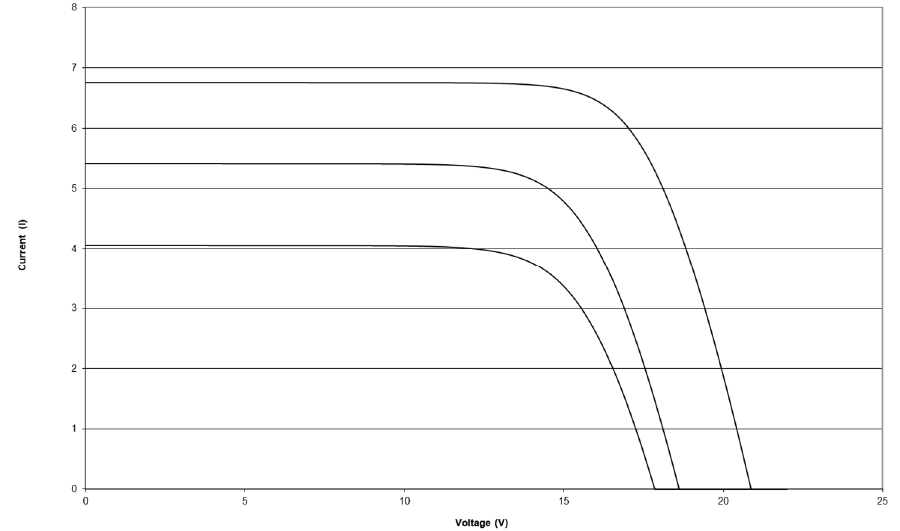
Figure 2. I–V curve for different solar irradiances.